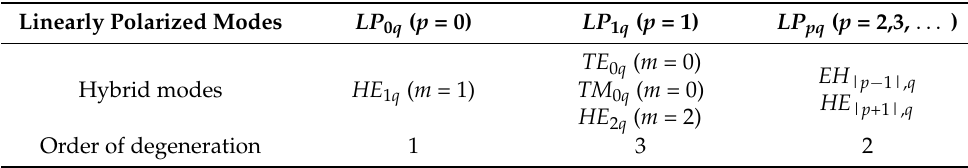
Table 1. Correspondence between linearly polarized and hybrid modes.